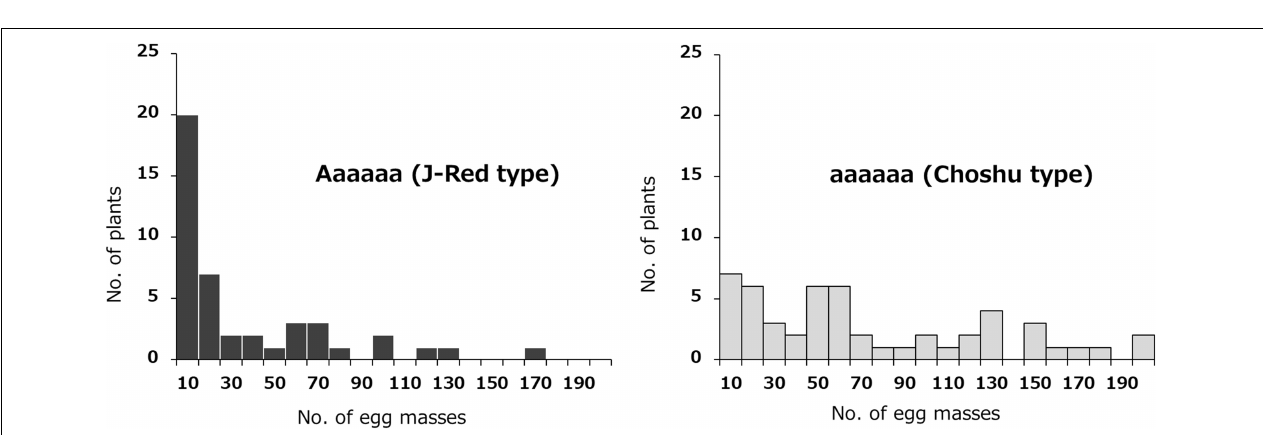
FIGURE 2 | Manhattan and Q-Q plots for sweet potato resistance to SP2 Meloidogyne incognita. (A) Manhattan plot. X -axis: the chromosomal number; Y -Axis: -log 10 (P). The red line represents the significance threshold from the false Discovery rate (FDR) based on the Benjamini–Hochberg procedure (BH) (Benjamini and Hochber, 1995). The blue line represents the significance threshold − log 10 (1 × 10 − 4 ). (B) Q-Q plot.